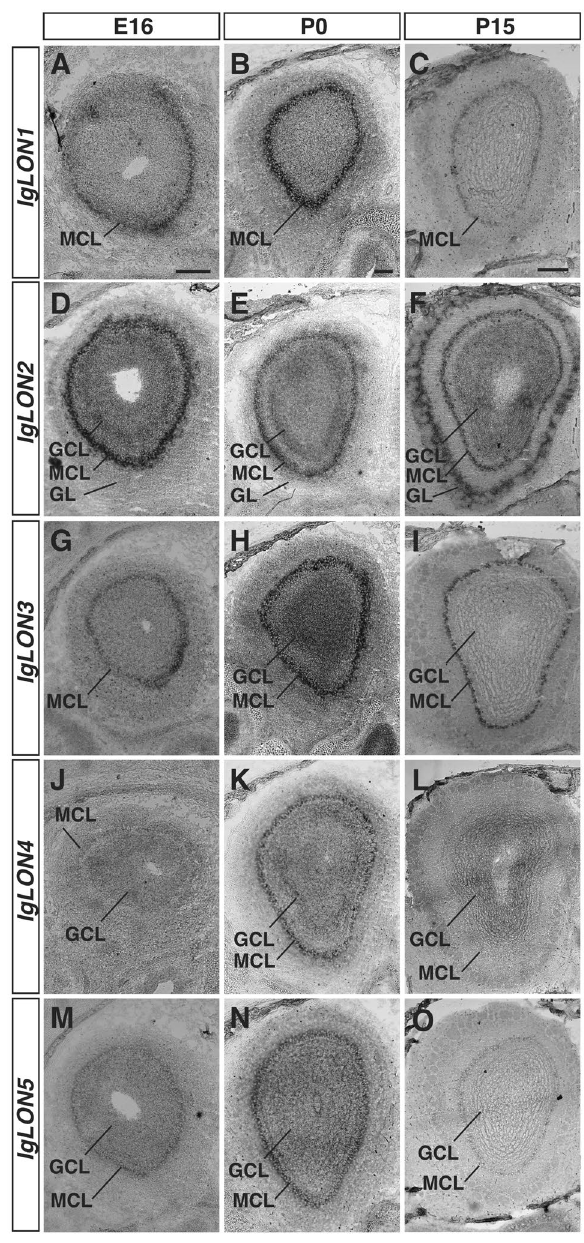
Figure 3. IgLONs mRNA expression in the developing olfactory bulb (OB). In situ hybridization of coronal sections of OB from embryonic day (E) 16 and postnatal day (P) 0 and 15 mice with antisense cRNA probes for IgLON transcripts. IgLON1 mRNA is detected in the mitral cell layer (MCL) of the OB at E16 and is maintained at P0 and P15 ( A – C ). IgLON2 mRNA expression is observed in the MCL and in the granule cell layer (GCL) of the OB at E16, P0, and P15 ( D – F ). By P15, IgLON2 expression is also detected in the glomerular cell layer (GL) ( F ). IgLON3 is expressed in the MCL at E16, P0, and P15, and could also be detected in the GCL at P0 ( G – I ). IgLON4 mRNA expression is observed at low levels in the GCL and in the MCL at E16 ( J ). Its expression in these regions is increased at P0 but is downregulated in the MCL at P15 ( K , L ). IgLON5 mRNA is detected in the MCL and GCL at E16 ( E ) and P0 ( N ) and at lower levels at P15 ( O ). Scale bars = 200 µm ( A , B , D , E , G , H , J , K , M , N ) and 500 µm ( C , F , I , L , O